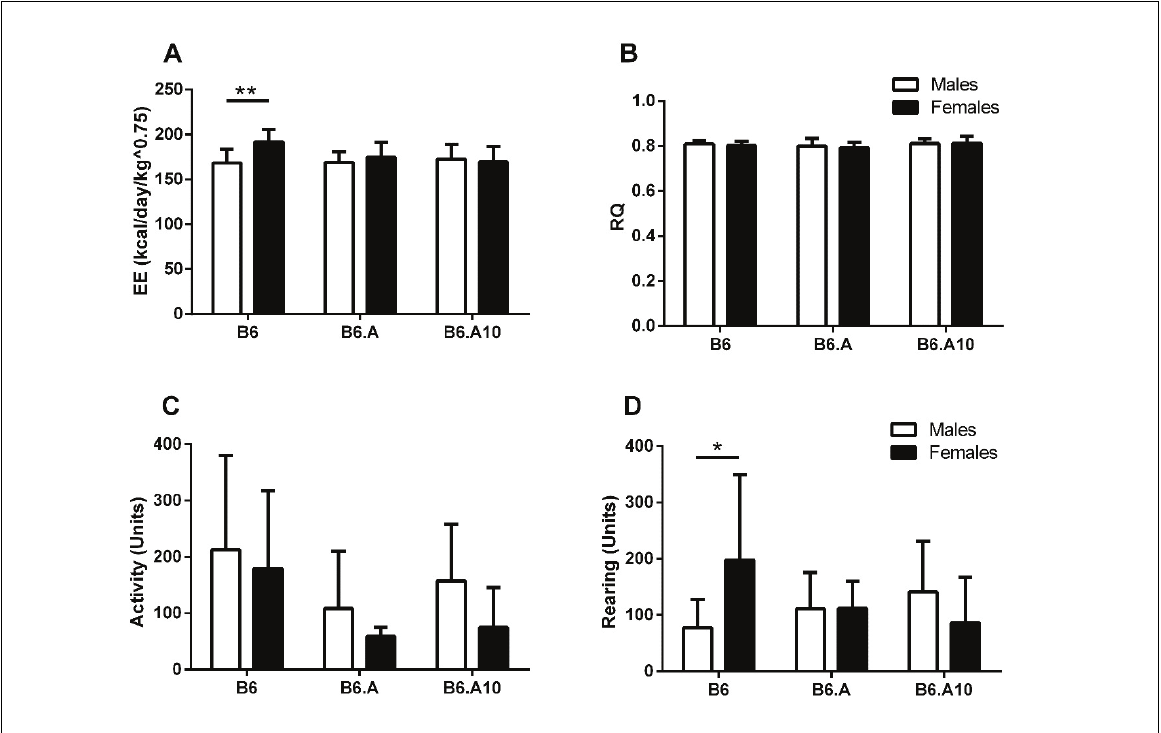
Figure 2. Energy expenditure (A), respiratory quotient (B), physical activity (C) and rearing (D) gender differences in B6, B6.A and B6.A10